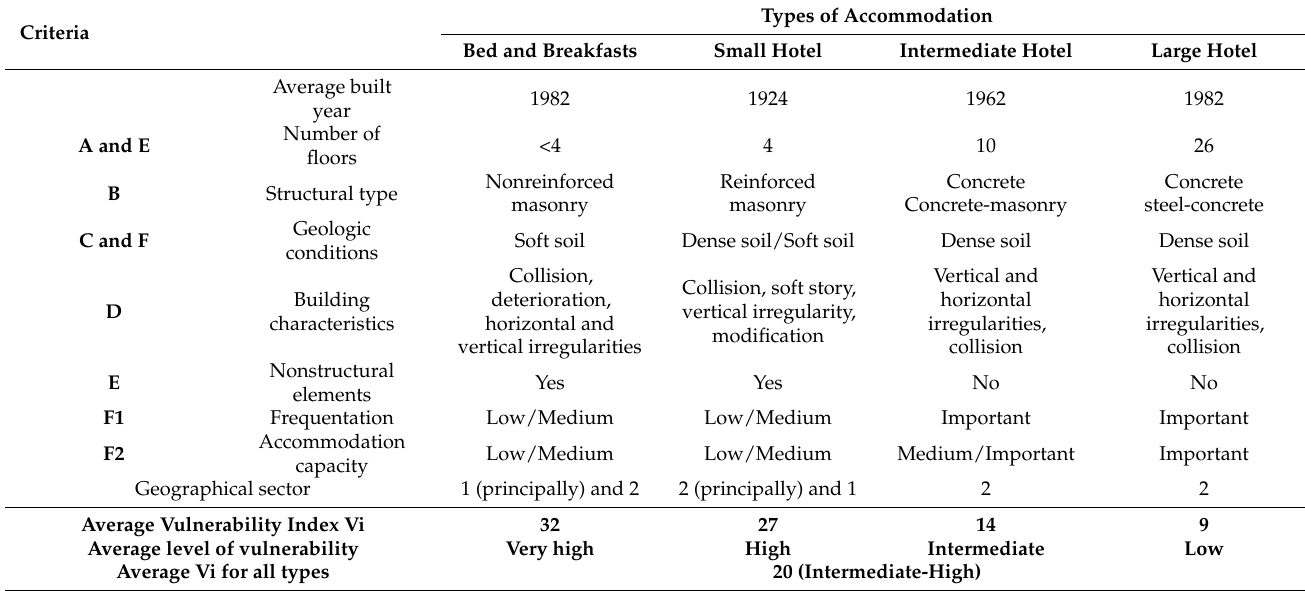
Table 9. Average value of criteria for the vulnerability index by types of